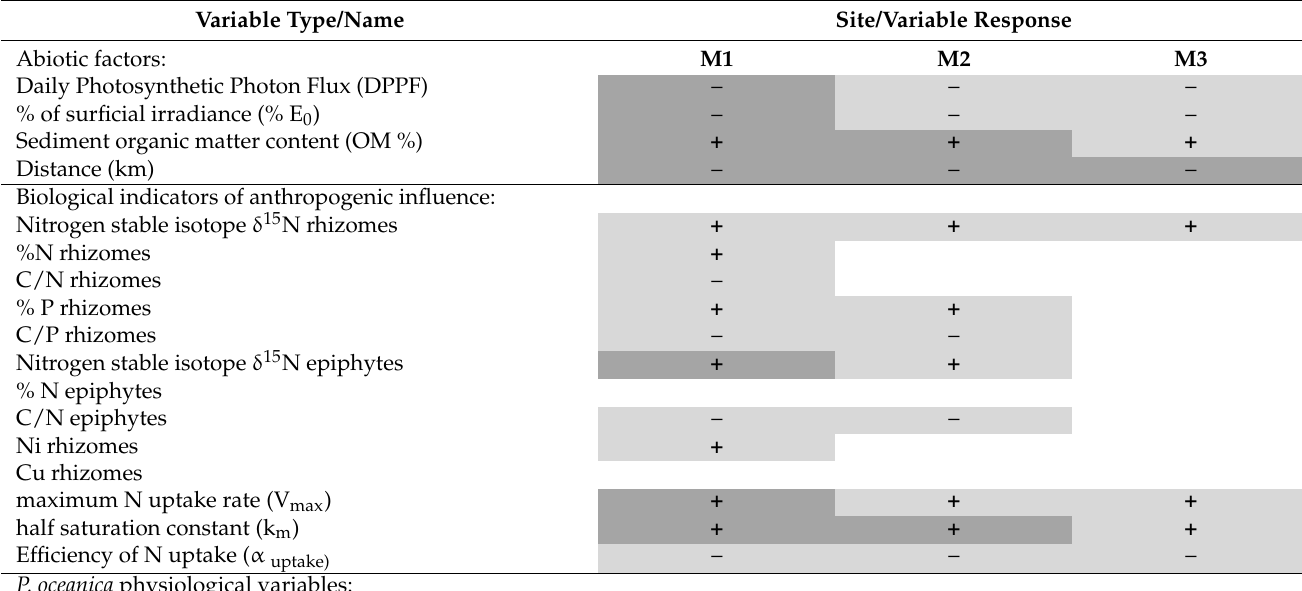
Figure 5. Meadow structural descriptors measured at the four meadow sites (M1–M4) in autumn. ( a ) Meadow cover, ( b ) shoot density, ( c ) rhizome length and ( d ) % plagiotropic rhizomes. Different letters indicate significant differences among sites (Tukey test, p < 0.05). Table 2. Summary of abiotic and biotic variations of the three P. oceanica meadow sites subjected to the off-shore nutrient discharges (M1, M2 and M3) relative to the reference site (M4). The grey scale indicates the intensity of the deviation, and the positive (+) and negative (–) signs indicate an increase or decrease in the variable, respectively. The white colour indicates no difference from the reference